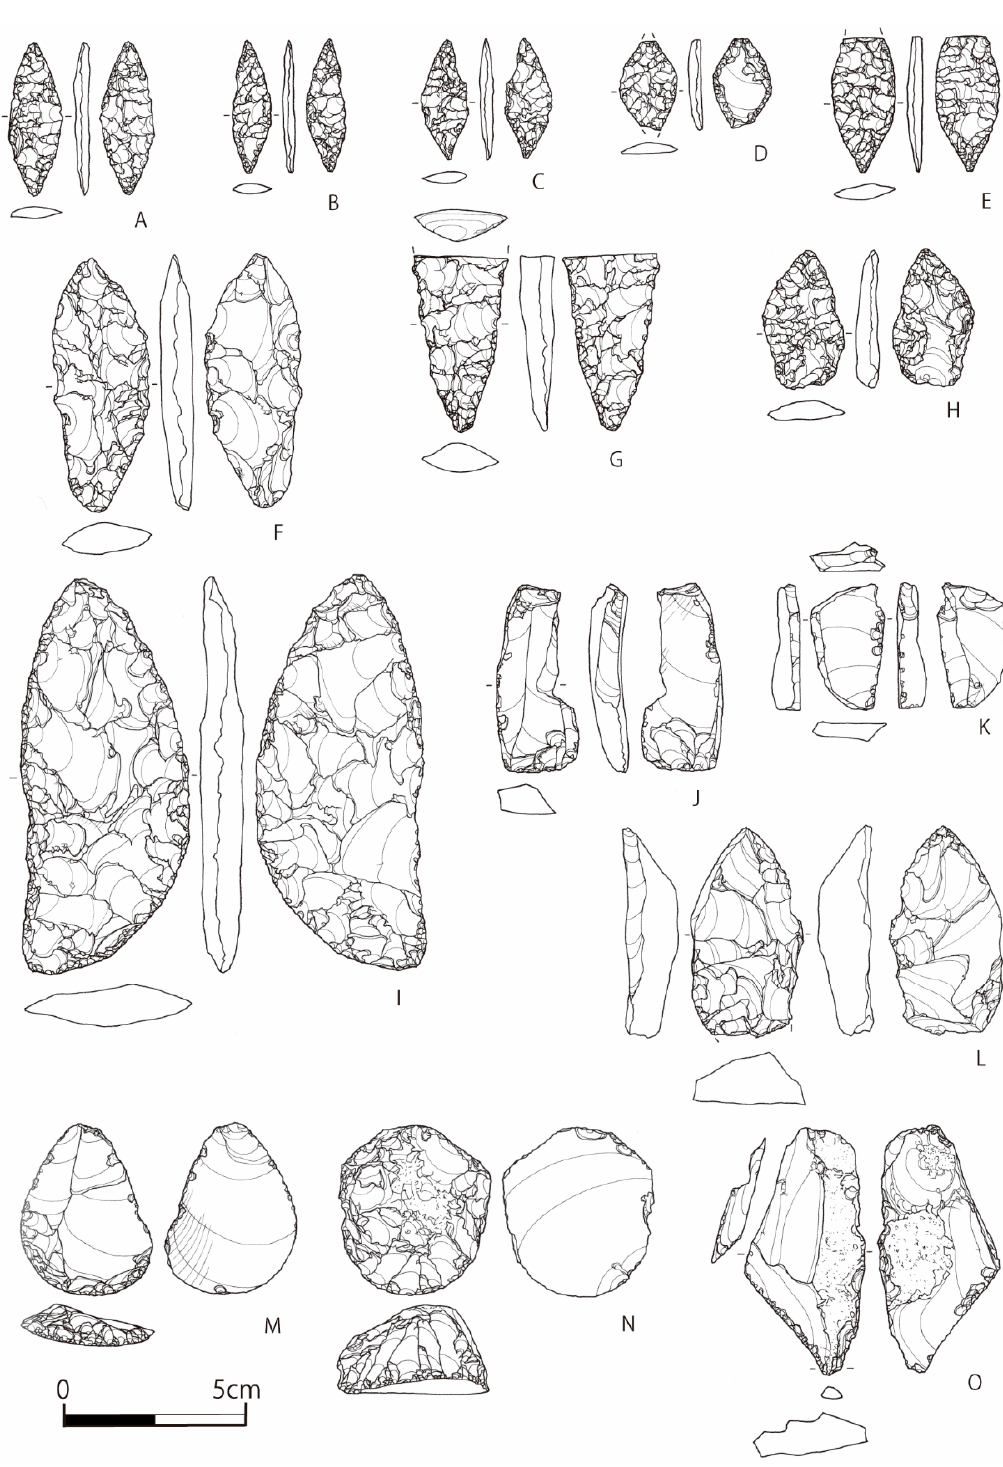
Figure 5. Stone artefacts in the Taisho-3 techno-complex. Examples from the Taisho-3 site in eastern Hokkaido: ( A–D , F ) bifacial points; ( E , G ) broken bifacial points; ( H , I ) bifacial tools; ( J–L ) burins; ( M , N ) end-scrapers; ( O ) drill. Reproduced from [90].